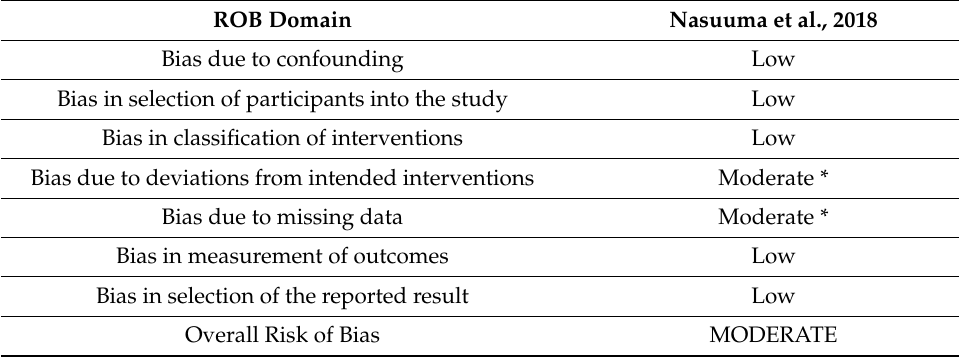
Table 2. Rise of bias assessment (non-randomized studies using ROBINS-1 tool). ROB